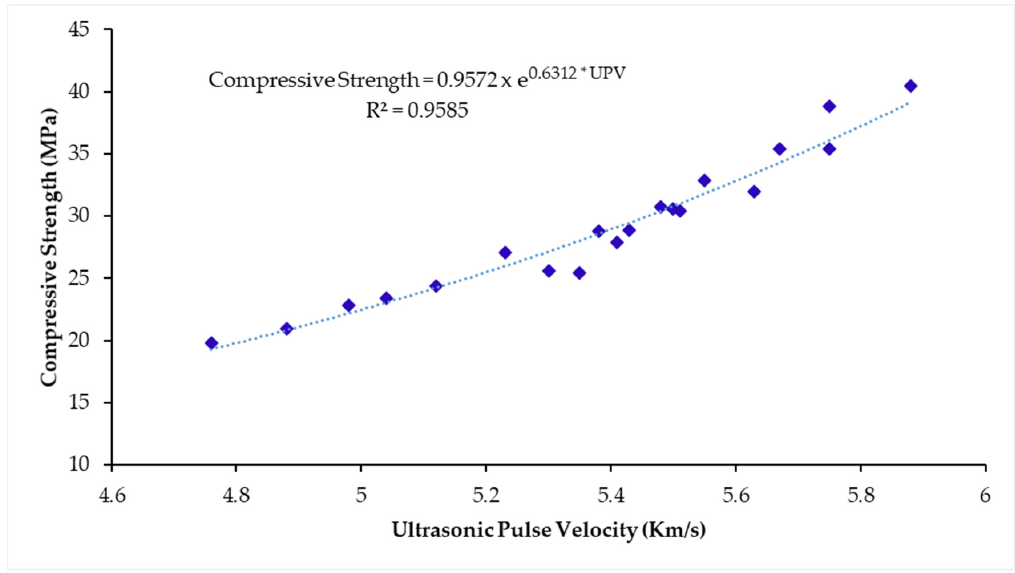
Figure 14. Regression relation between compressive strength and UPV of WSA incorporated mixes. It is well-known that the travel time or velocity of an ultrasonic wave is affected by the nature of the propagating medium. Therefore, the density of the medium is of prime importance. Hence, the relation between unit weight and UPV is explicitly shown in Fig- ure 15. The correlation coefficients for unit weight and ultrasonic pulse velocity are 0.968, 0.9856, 0.9825, and 0.9777 at 7, 28, 56, and 90 days respectively. Therefore, good relation is exhibited between the regression curve and data points.